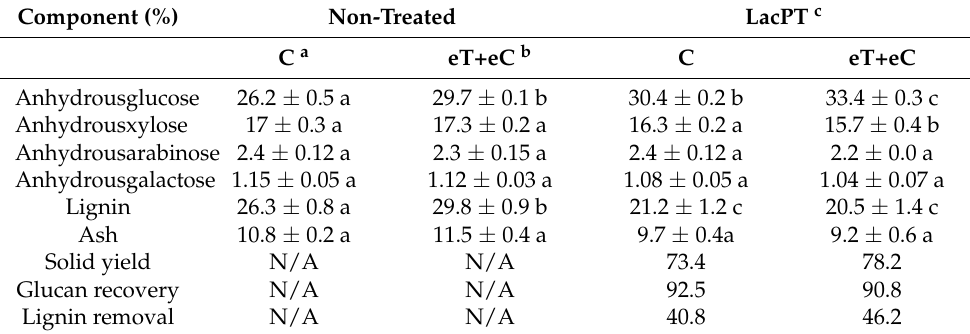
Table 1. Percentage (%) of the chemical composition of non-treated and pretreated P. maximum samples in different clime conditions. Mean values ± SD ( n = 3) marked with other letters at the same line are significantly different ( p < 0.05, Tukey’s test). Component (%) LacPT